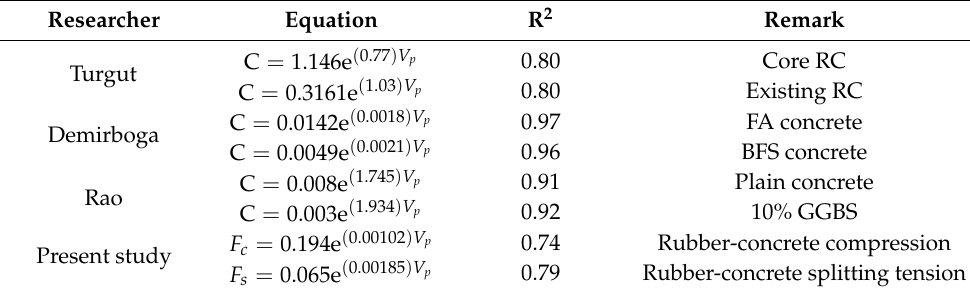
Figure 8. Relationship between UPV and Splitting tensile strength. Table 8. Proposed equations with other